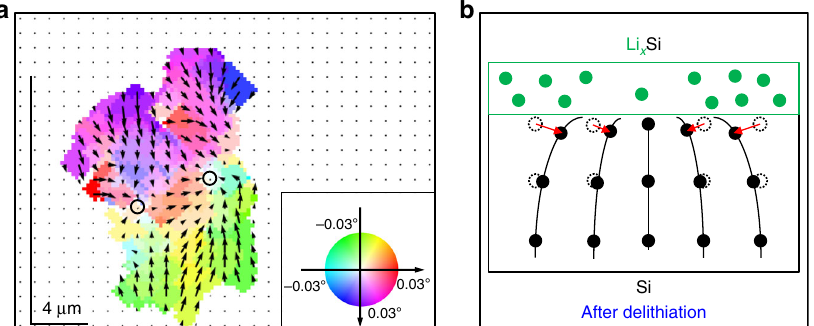
Fig. 3 Quantitative analysis of the early-stage defects. Result of 3D RSM ( a ). The direction and magnitude of the lattice tilt are expressed both by false colors (the reference color wheel is found in the inset) and arrows. The lattice tilt is the weakest at the center of the two defects, as indicated by the two circles in a . Cross-sectional schematic representation of the tilted lattice ( b ). The lattice is tilted toward the center of the defect, which is attributed to a lower lithium concentration in the defective area after